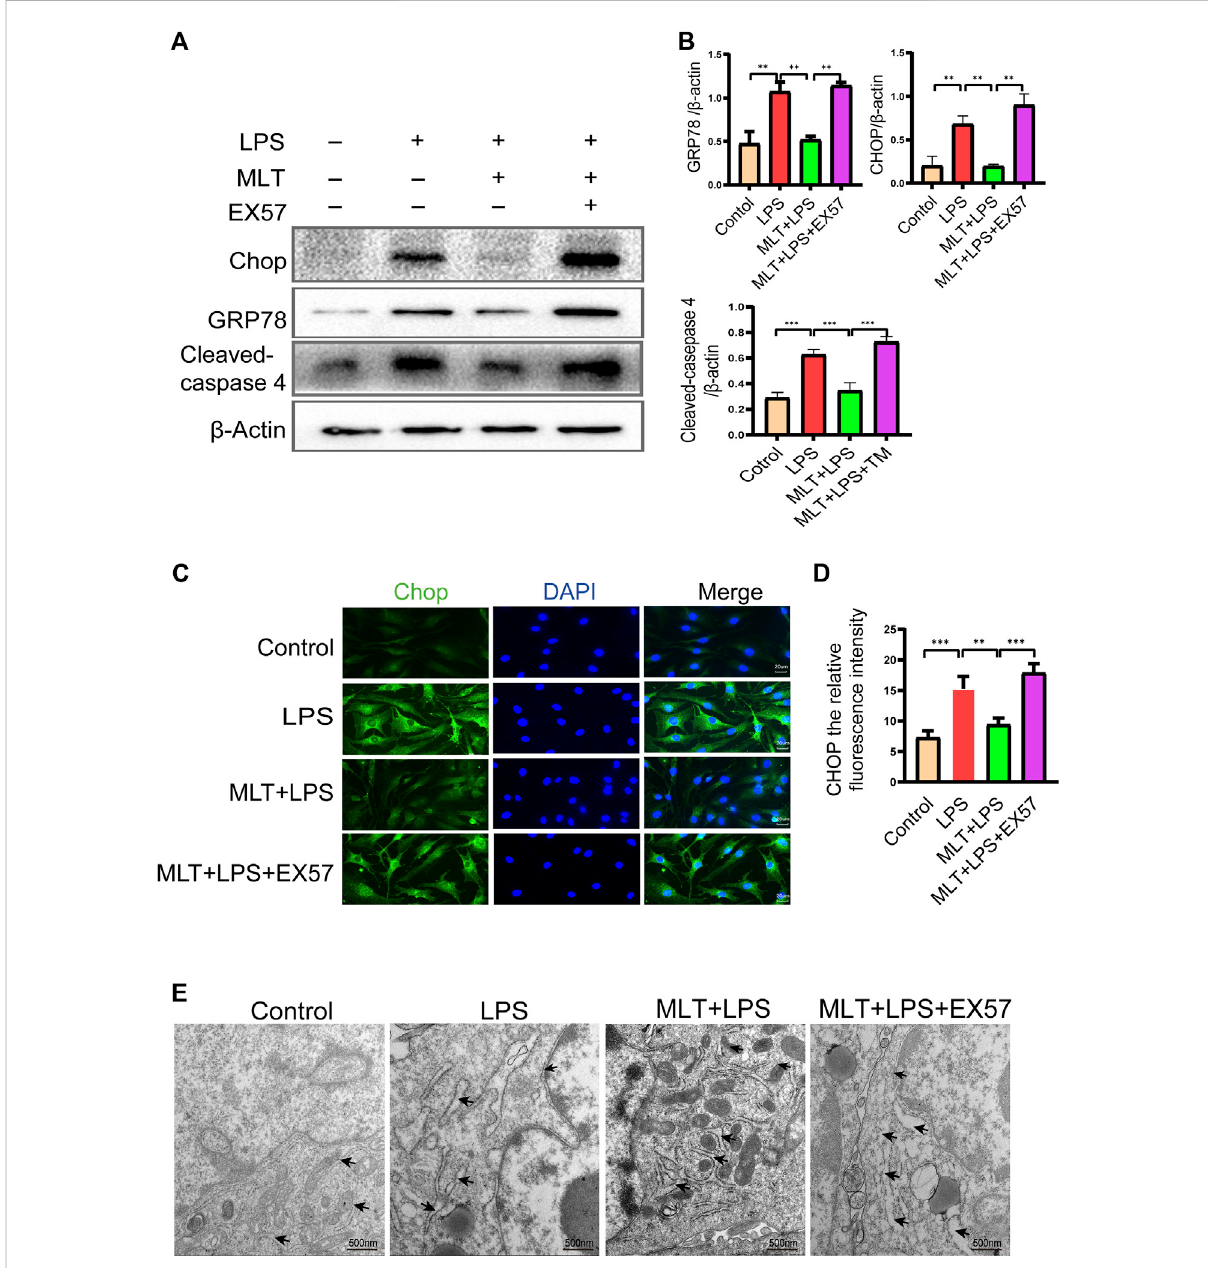
FIGURE 5 EX527 attenuated the inhibitory effect of melatonin on the endoplasmic reticulum stress of human chondrocytes induced by in fl ammation. (A,B) Expression levels of GRP78, C/EBP homologous protein (CHOP) and cleaved caspase-4 was determined by western blotting. (C,D) A representative CHOP level was detected by immuno fl uorescence staining to the endoplasmic reticulum. ImageJ was used to detect the fl uorescence intensity of CHOP (bar, 20 μ m). (E) The effect of altered endoplasmic reticulum morphology was observed with transmission electron microscopy (bar, 500 nm (black arrows refer to the endoplasmic reticulum); TM, tunicamycin; EX527, a classic sirtuin 1 inhibitor. The experiment was repeated three times independently. All values are shown as mean ± standard deviation. * p < 0.05, ** p < 0.01, *** p < 0.001, **** p